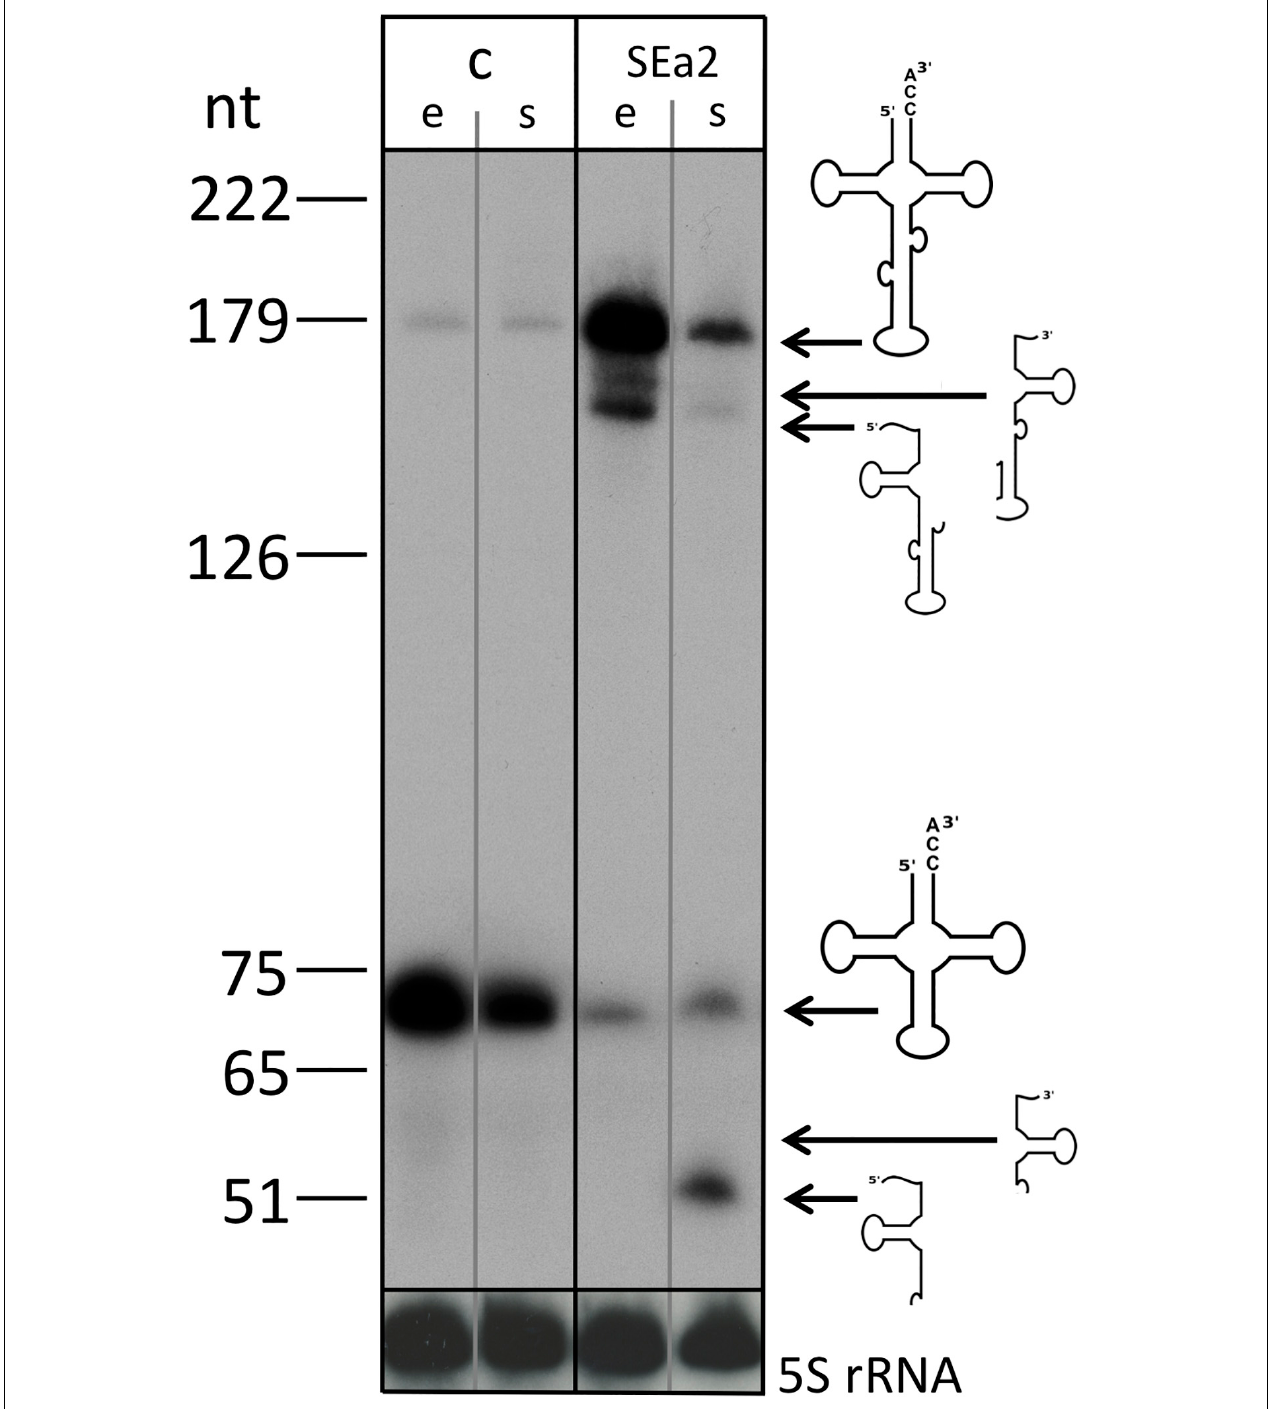
FIGURE 5 | tRNA maturation is severely impeded in CRISPRi cells. RNA was isolated from control cells (lane c, HV30 × pTA232) and cells expressing crRNA SEa2 (lane SEa2, HV30 × pTA232SEa2) (lanes e: cells were grown to exponential phase, lanes s: cells were grown to stationary phase). RNA was separated by 8% PAGE and transferred to nylon membranes. Blots were hybridized with a probe against the tRNA intron that also detects the mature tRNA (upper panel; lower panel: the same blot was hybridized with a probe against the 5S rRNA). Expression of crRNA SEa2 results in accumulation of unspliced tRNA and processing intermediates. Only very small amounts of mature tRNA can be detected. A DNA size marker is given at the left. Precursors, processing intermediates and the mature product are shown schematically on the right.